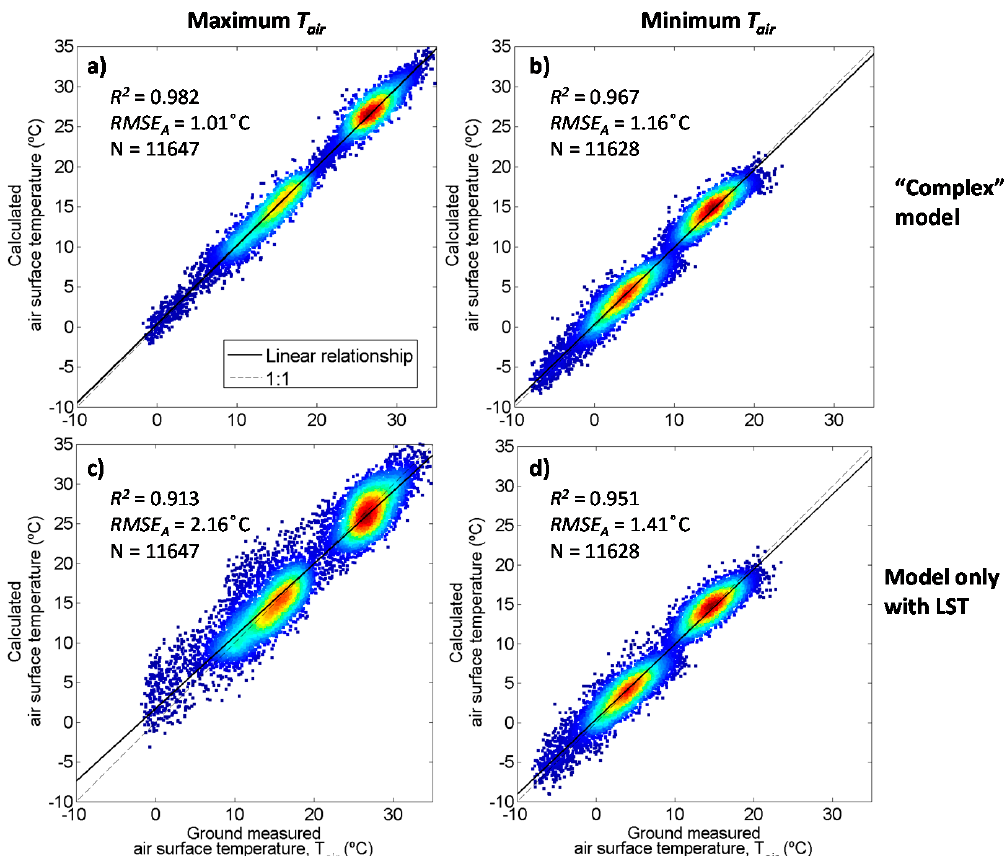
Figure 7. Idem to Figure 6, but corresponding to performance metrics obtained with the “complex” model.